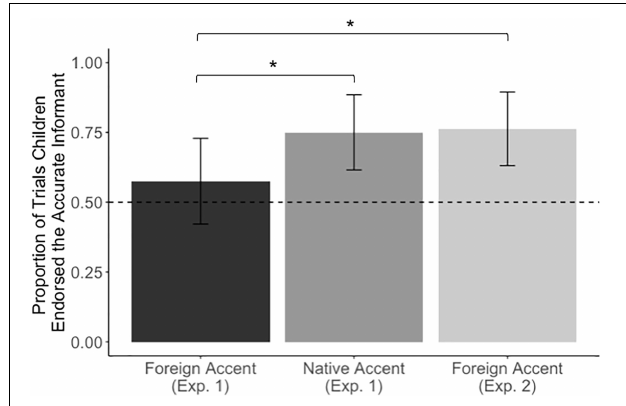
FIGURE 2 | Proportion of trials in each experimental condition in which children endorsed the novel label provided by an accurate informant over an inaccurate (grammatically incorrect) informant. Error bars indicate 95%